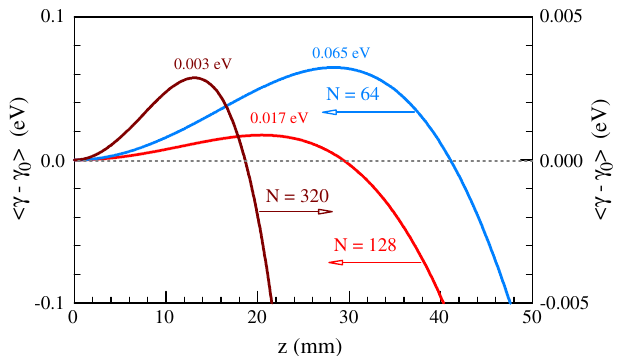
FIG. 23. (Color) (Direct method). Average energy increment i vs axial distance z for different particle numbers. It h (cid:5) (cid:4) (cid:5) 0 i > 0 holds for small z ( (cid:1) 0 ), which contra- is seen that h (cid:5) (cid:4) (cid:5) 0 dicts the strict qualitative result, Eq.